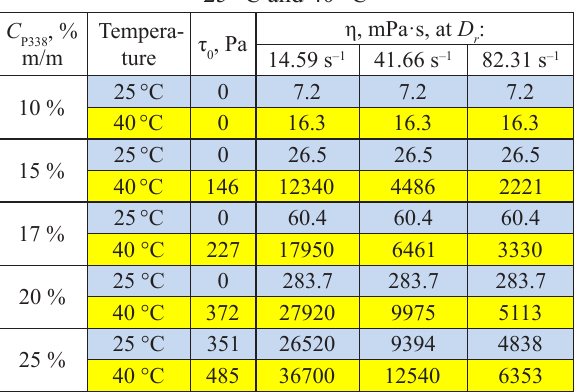
Fig. 17. Rheograms (at 40 °С) of aqueous solutions of P338 at concentration: 1 – 10 %; 2 – 15 %; 3 – 17 %; 4 – 20 %; 5 – 25 Rheological parameters of P338 aqueous solution at 25 °С and 40 °С